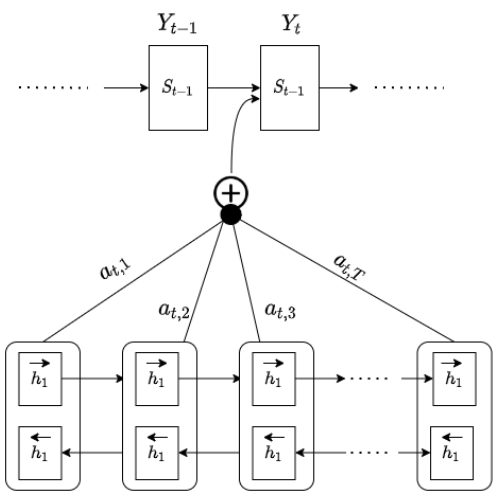
Figure 6. Long short-term memory generates attention from forwarding and backward hidden